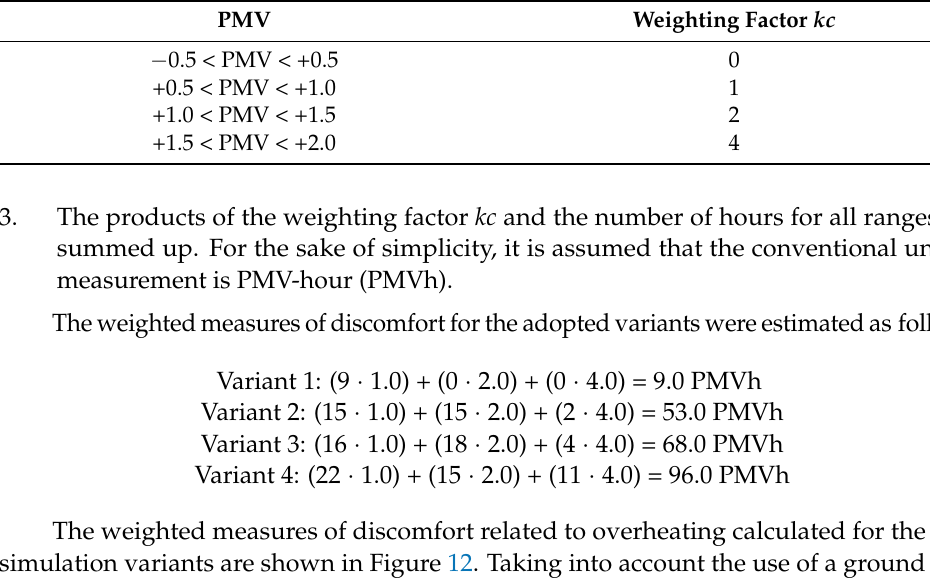
Table 6. Method of calculating the weighting factor for measuring overheating discomfort.